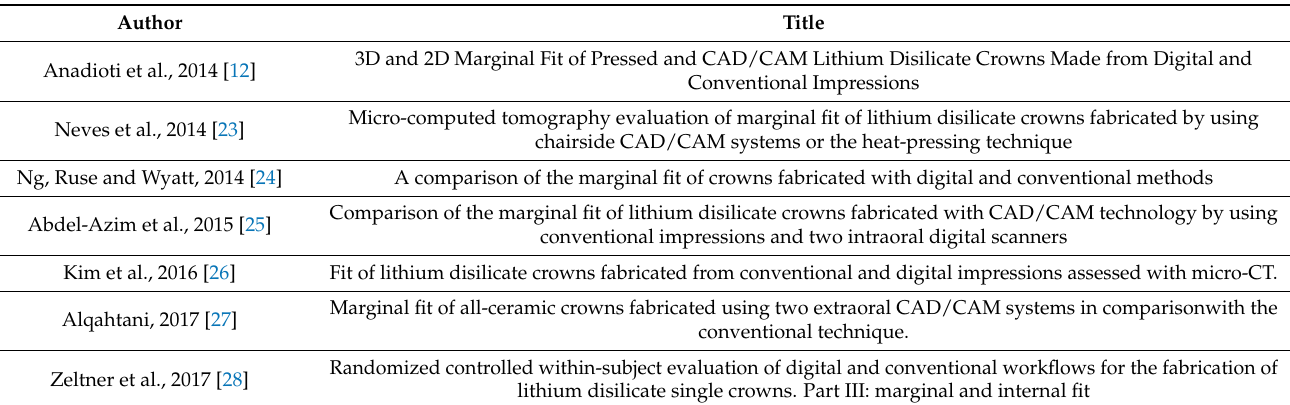
Table 2. Studies included in the analysis.